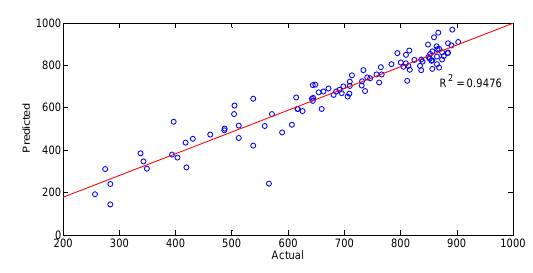
Figure 14. Correlation between actual and predicted NDVI values of 100 randomly selected pixels at t p = 69.